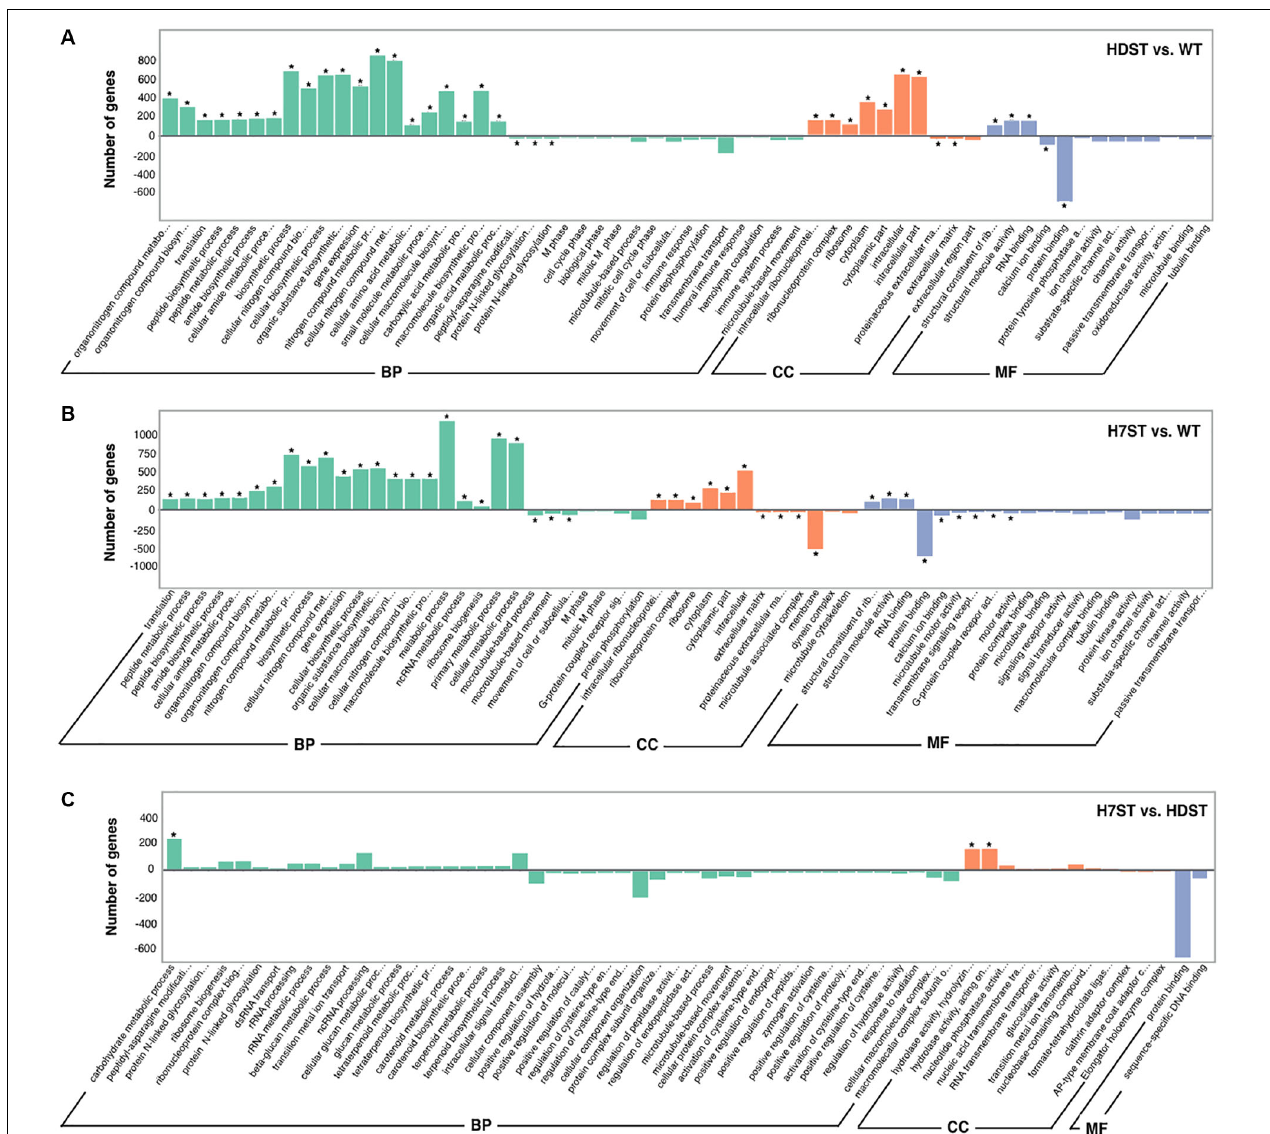
FIGURE 4 | Gene ontology functional classification of differentially expressed genes. The x-axis indicates the enriched GO terms, whereas the y-axis indicates the number of differentially expressed genes in the HDST vs. WT (A) , H7ST vs. WT (B) , and H7ST vs. HDST (C) comparisons. Different colors are used to distinguish the biological process, cellular component, and molecular function GO categories. The enriched GO terms are marked with an asterisk. The ± numbers represent the up-/down-regulated